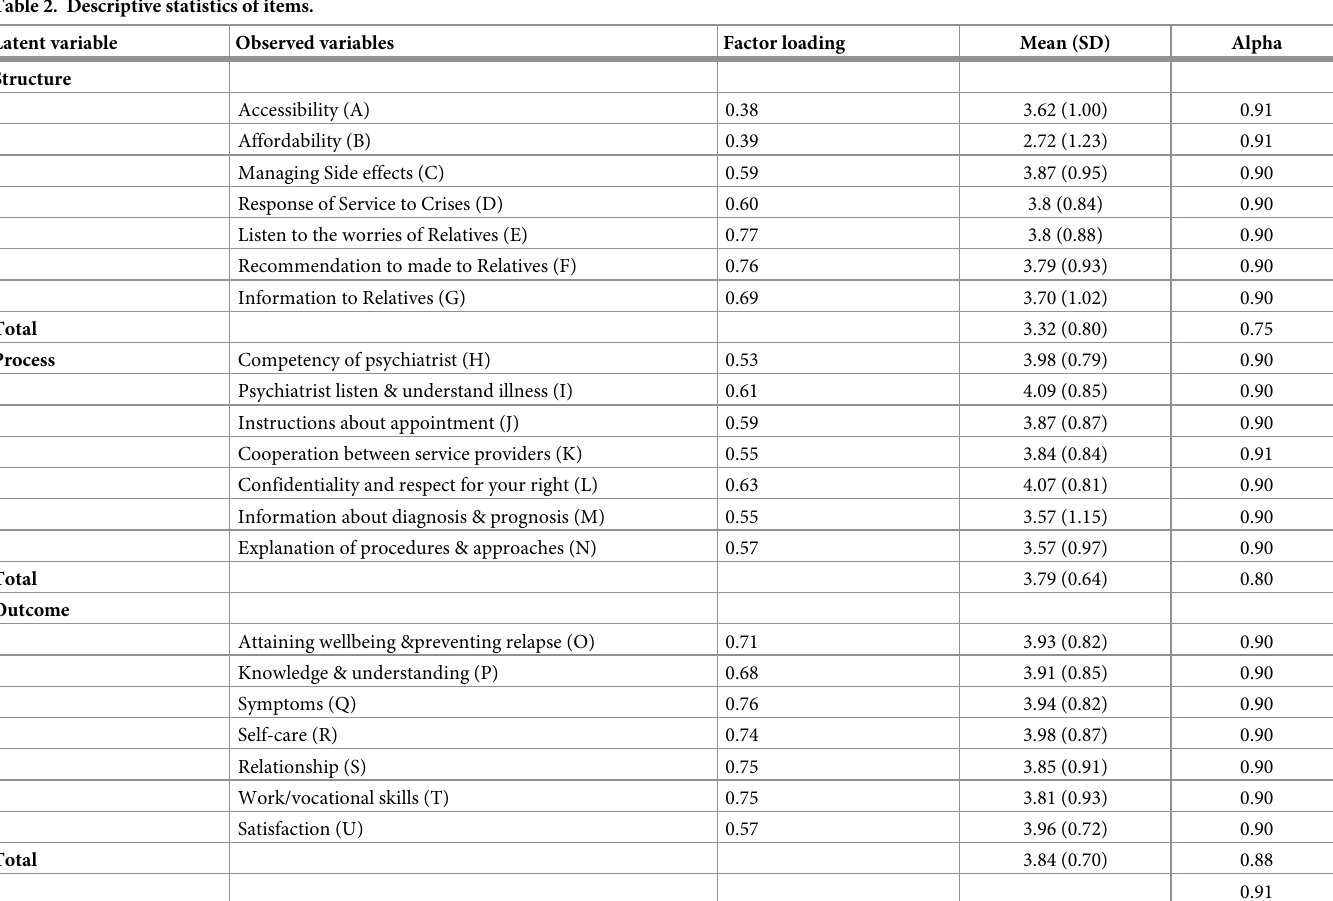
Table 2. Descriptive statistics of